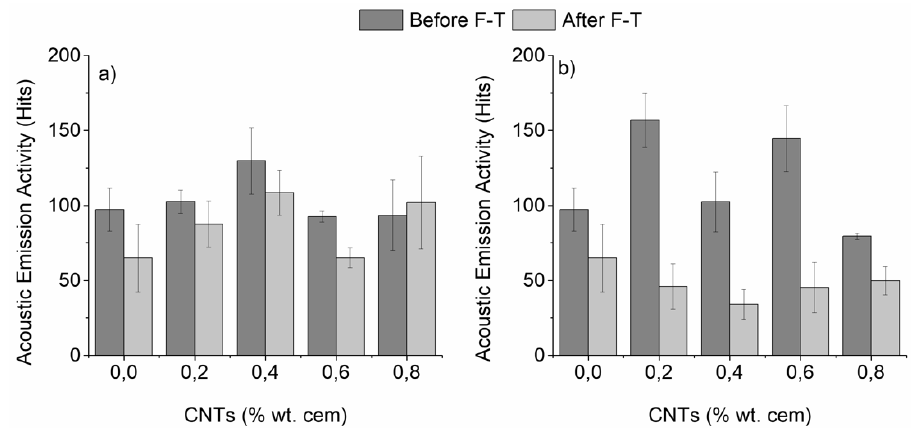
Figure 7. Acoustic emission activity of nano-mortars prepared with ( a ) superplasticizer and ( b ) surfactant as dispersive agent, as a function of F-T exposure (plain specimens have been added for